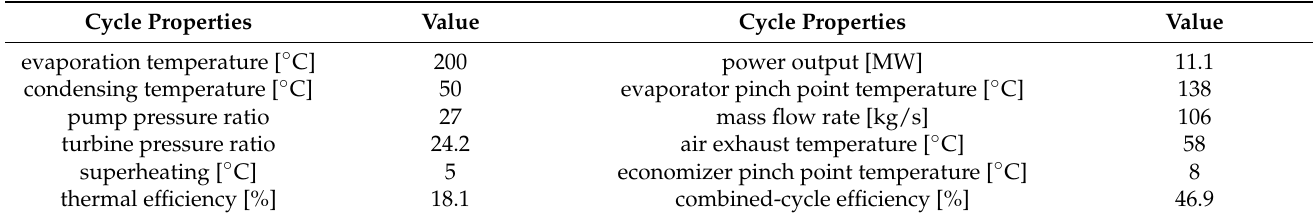
Table 4. On-design properties of designed ORC.